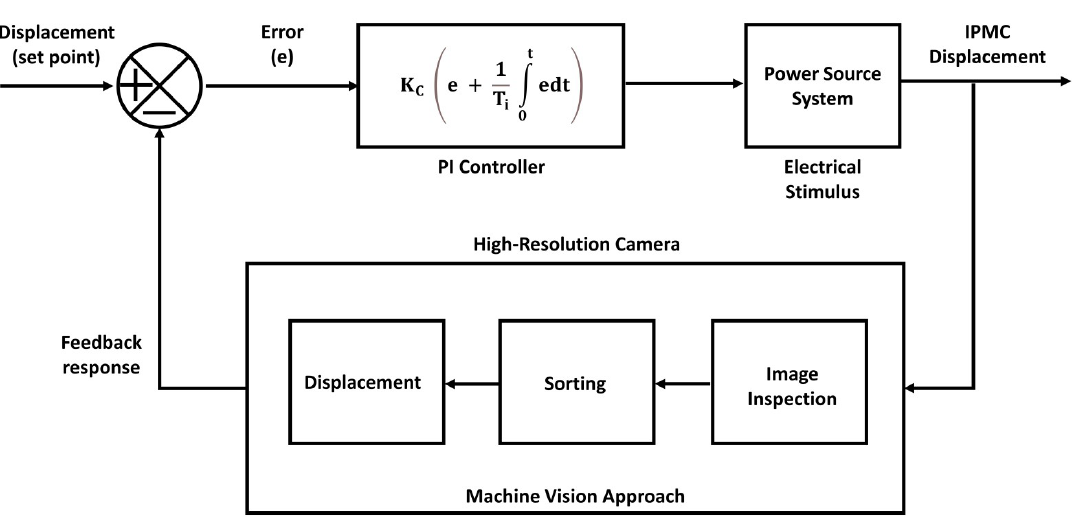
Figure 4. IPMC automatic closed-loop control system block diagram. The control parameters are Kc - controller gain and Ti - integral